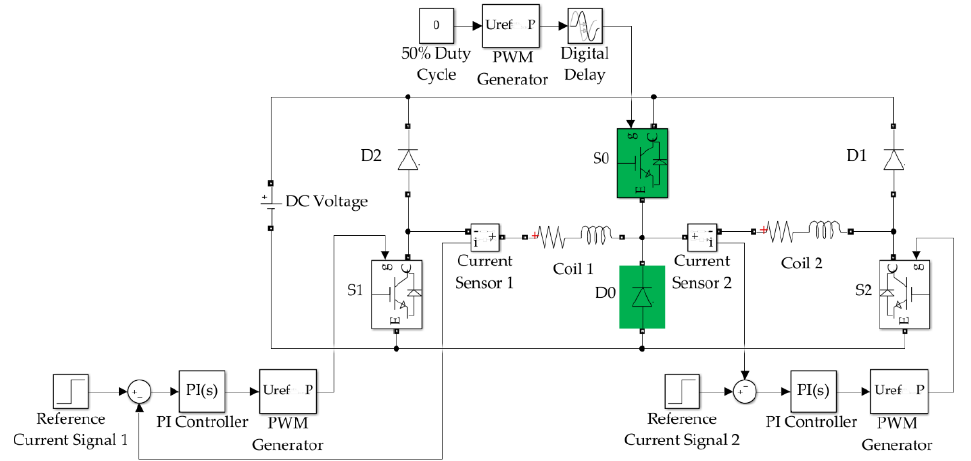
Figure 11. Current ripple of the SPA with a half-bridge topology.